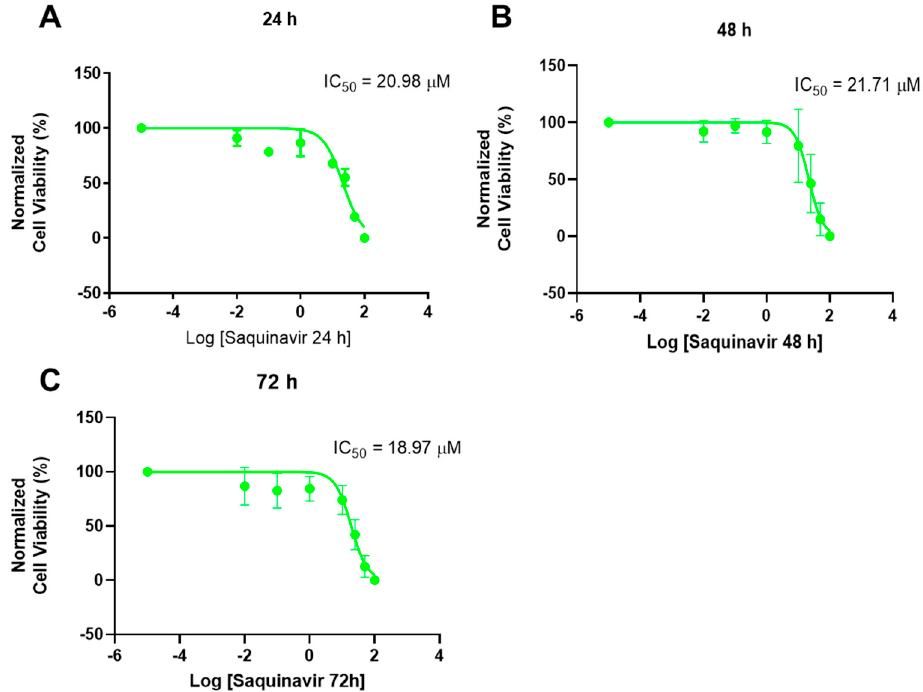
Figure 6. Dose-response curve and IC 50 of PC-3 after exposure to increasing concentrations of saquinavir (0.01 − 100 µ M) for 24 h ( A ), 48 h ( B ), and 72 h ( C ). Control cells were treated with 0.01%